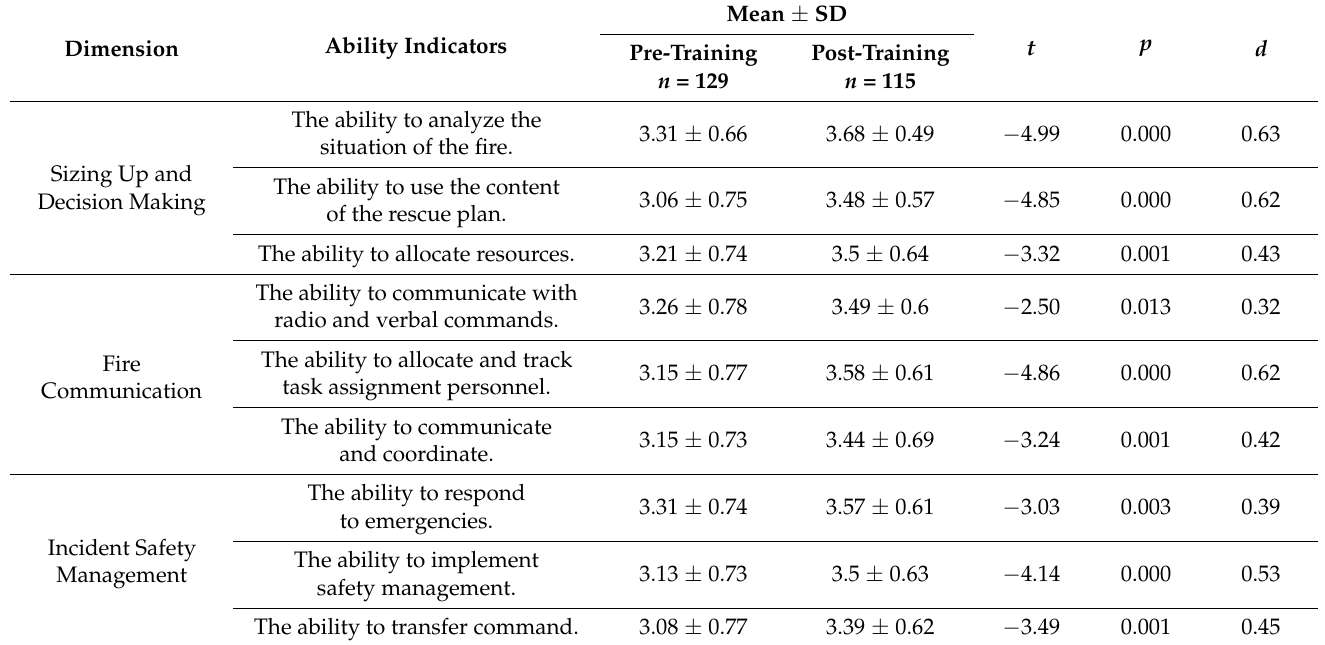
Table 8. T Test analysis of trainees’ self-assessment scores before and during the VRST training.